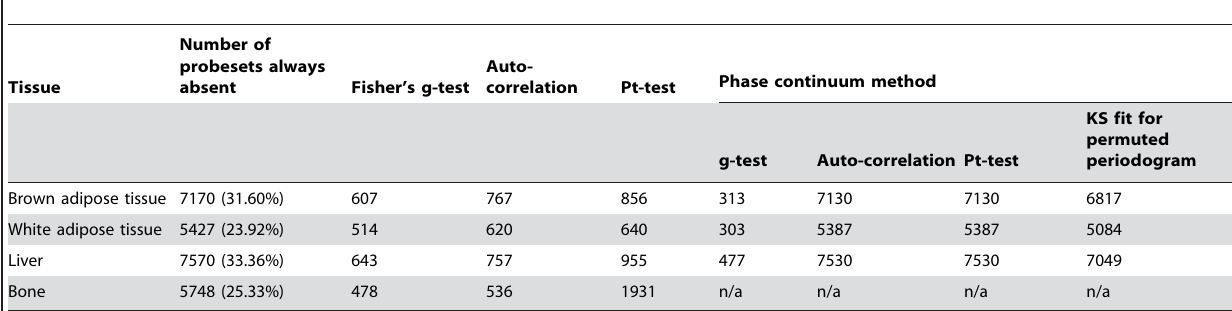
Table 1. Numbers of circadially oscillating ‘‘absent’’ genes as reported by different algorithms and testing strategies.